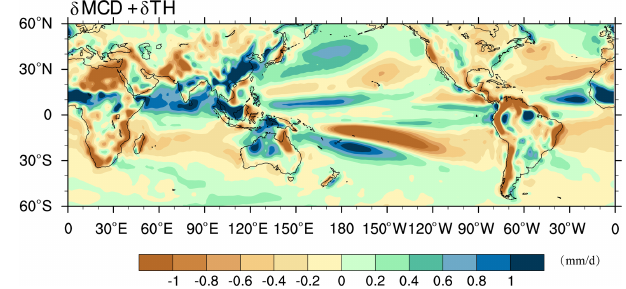
Figure 5. The estimated annual mean changes in the PmE (calcu- lated as the sum of the dynamic term and thermodynamic term) of the mid-Pliocene minus the PI control of the PlioMIP2 multi-model mean (units: mmd − 1